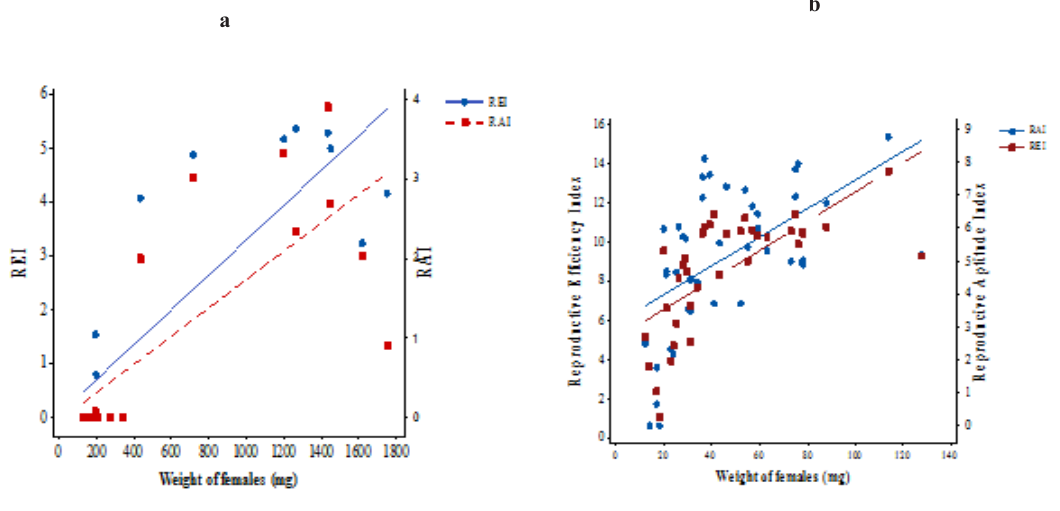
Figure 7: Reproductive Efficiency Index (REI) and Reproductive Affinity Index (RAI) vs. weight of females of R. microplus (a: Regression fit; R 2 - 46.4% and R 2 - 29.6% respectively), H. isaaci (b: Regression fit; R 2 - 82.4% and R 2 - 88.3%